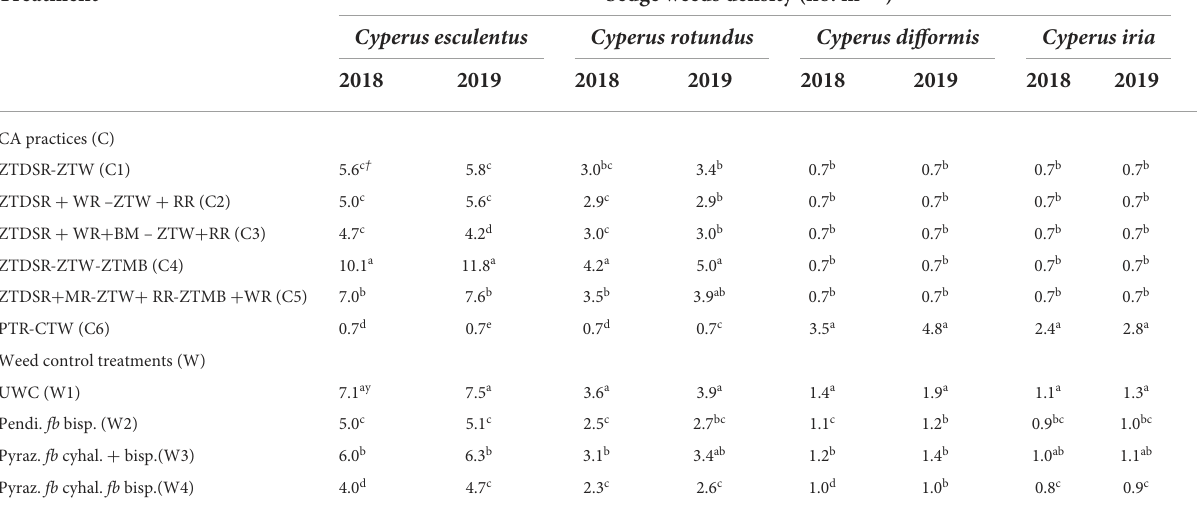
TABLE 6 Species-wise sedge weeds density (no. m − 2 ) in rice as influenced by CA and weed control treatments at 60 DAS/DAT during 2018 and 2019.